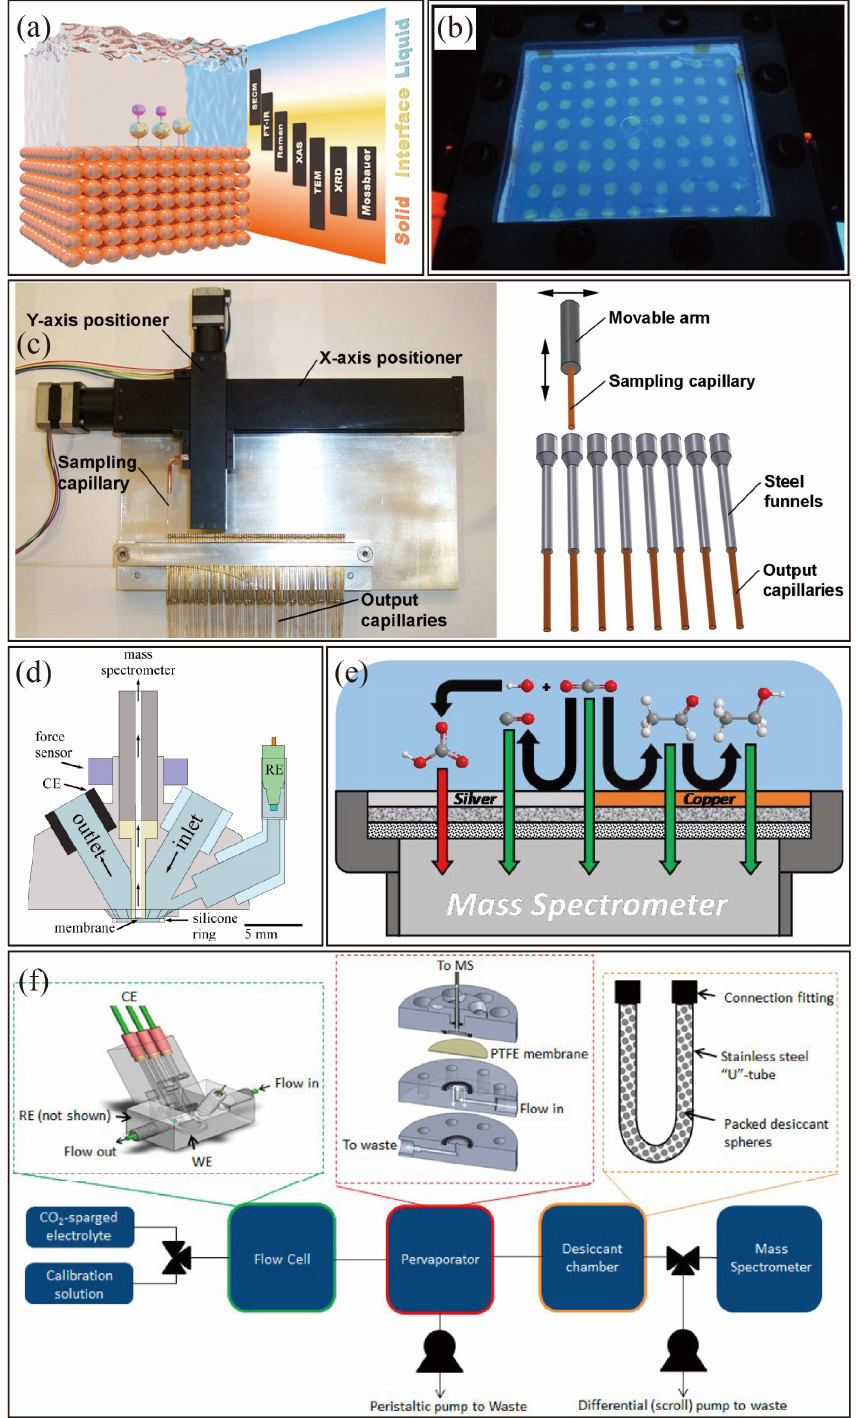
Figure 6. Characterization and high-throughput testing of catalyst candidates. ( a ) In situ characterization methods for solid, interface and liquid catalysts. Reprinted with permission from Ref. [104].